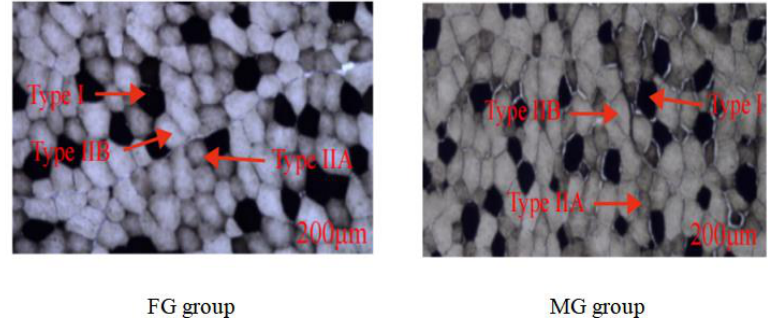
Figure 1. Serial sections of LT muscle stained with ATPase. FG group, flatland-grazing group; MG group, mountain-grazing group; bar: 200 μm.